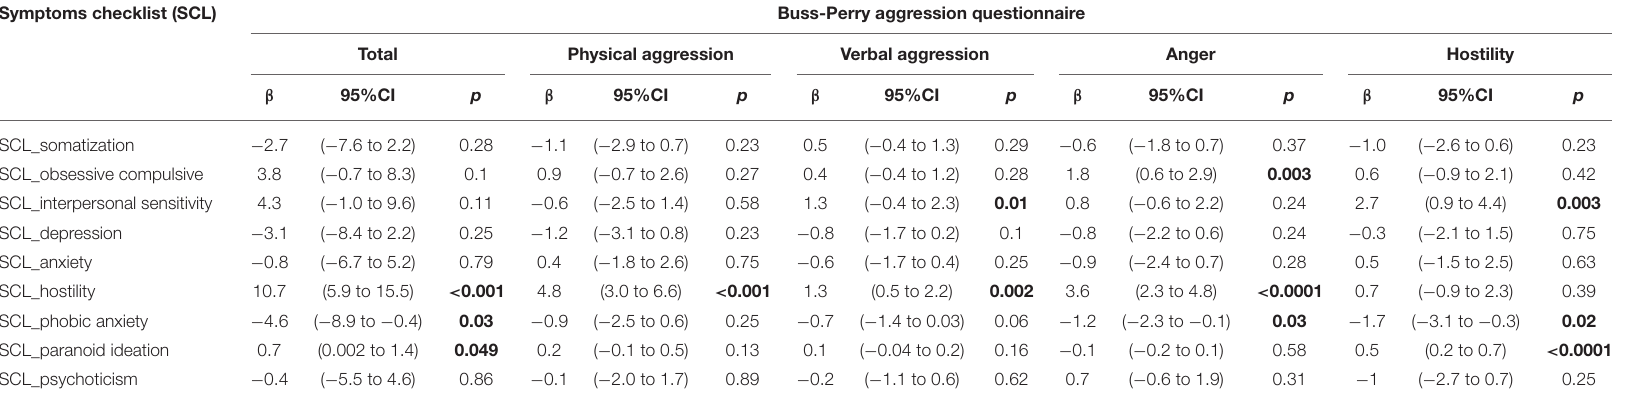
TABLE 4 | Symptoms severity (SCL-90-R) and Buss-Perry Aggression Questionnaire